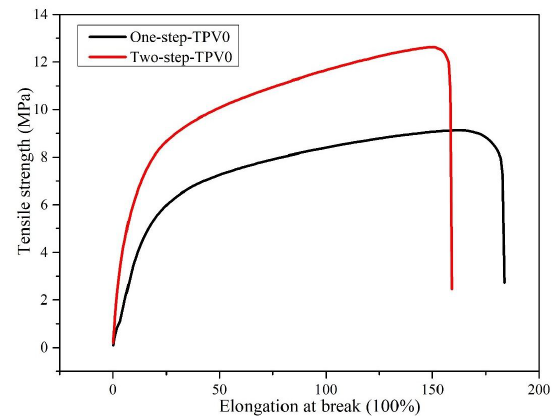
Figure 2: SEM micrographs of (a) one-step-TPV0, (b) and (c) one- step-TPV16, (d) two-step-TPV0, (e) and (f) two-step-TPV16.